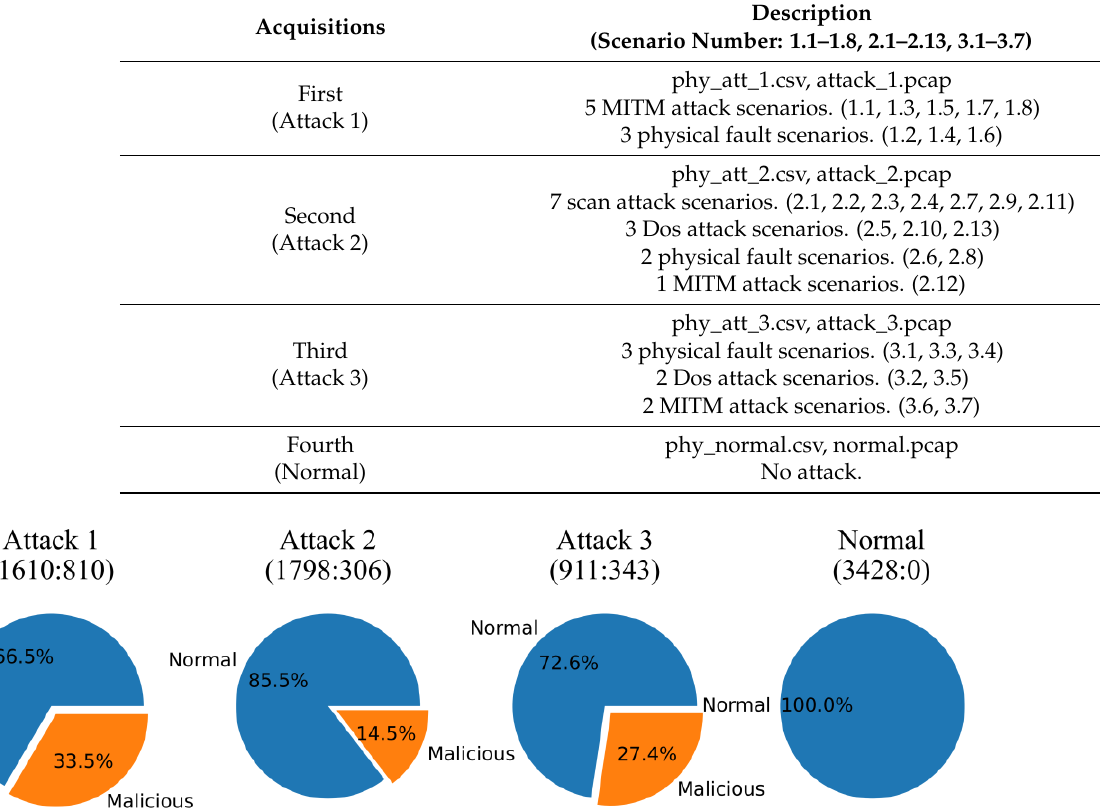
Table 1. Data acquisition and description.